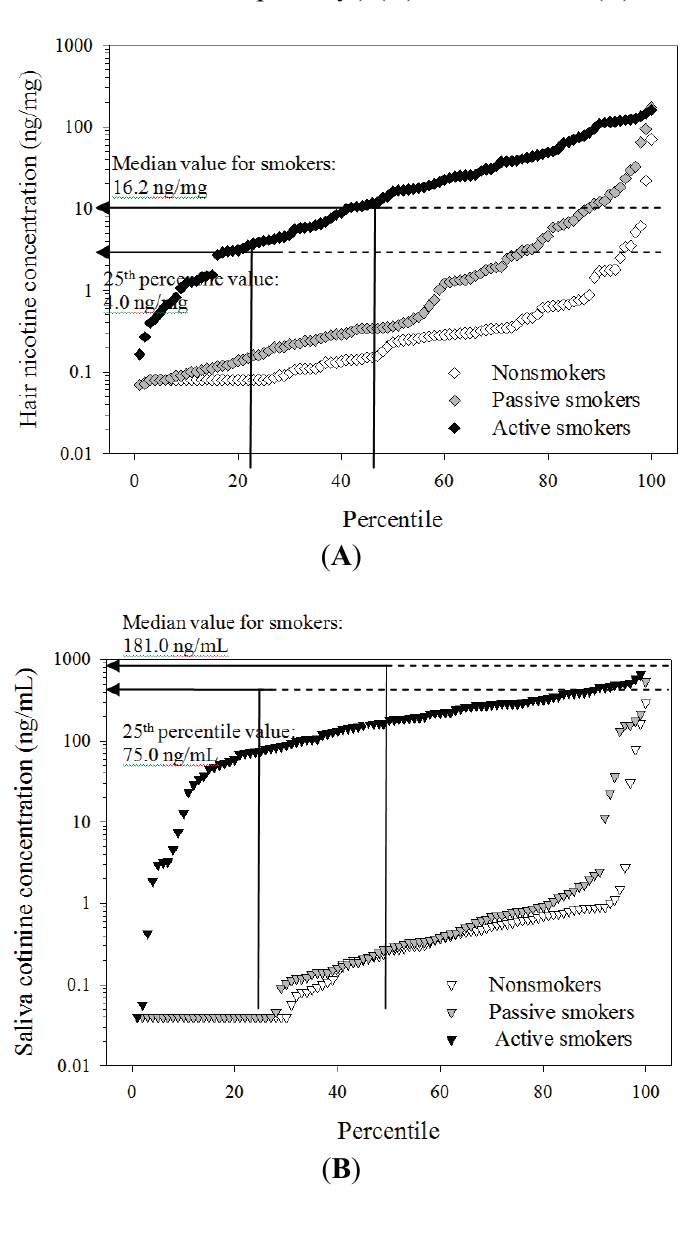
Figure 2. Distributions of hair nicotine and salivary cotinine concentrations by self-reported smoking status and 25th and 50th percentile values obtained from self-reported active smokers. Three different shades (black, gray, and white) represent for active smokers, passive smokers and nonsmokers, separately.) ( A ) Hair nicotine; ( B ) Salivary